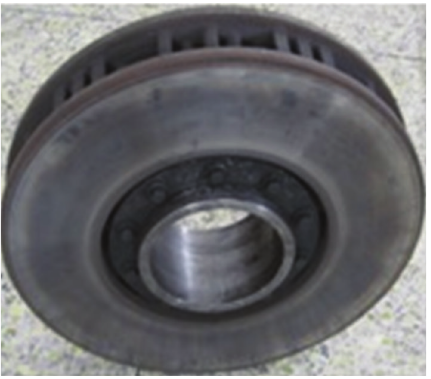
Figure 1: Brake disc.